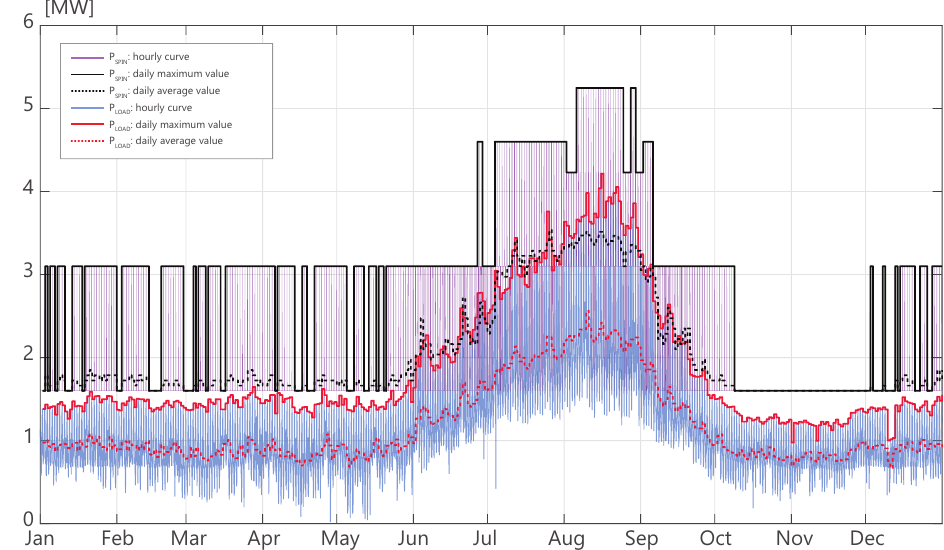
Figure 22. Hourly curve of spinning power P SPIN and load power P LOAD with the introduction of the BESS and RES envisaged in the objective of 100% of the Decree. Table 17. Annual operating data of the generators on the typical year with BESS and RES envisaged by the 100% objectives of the